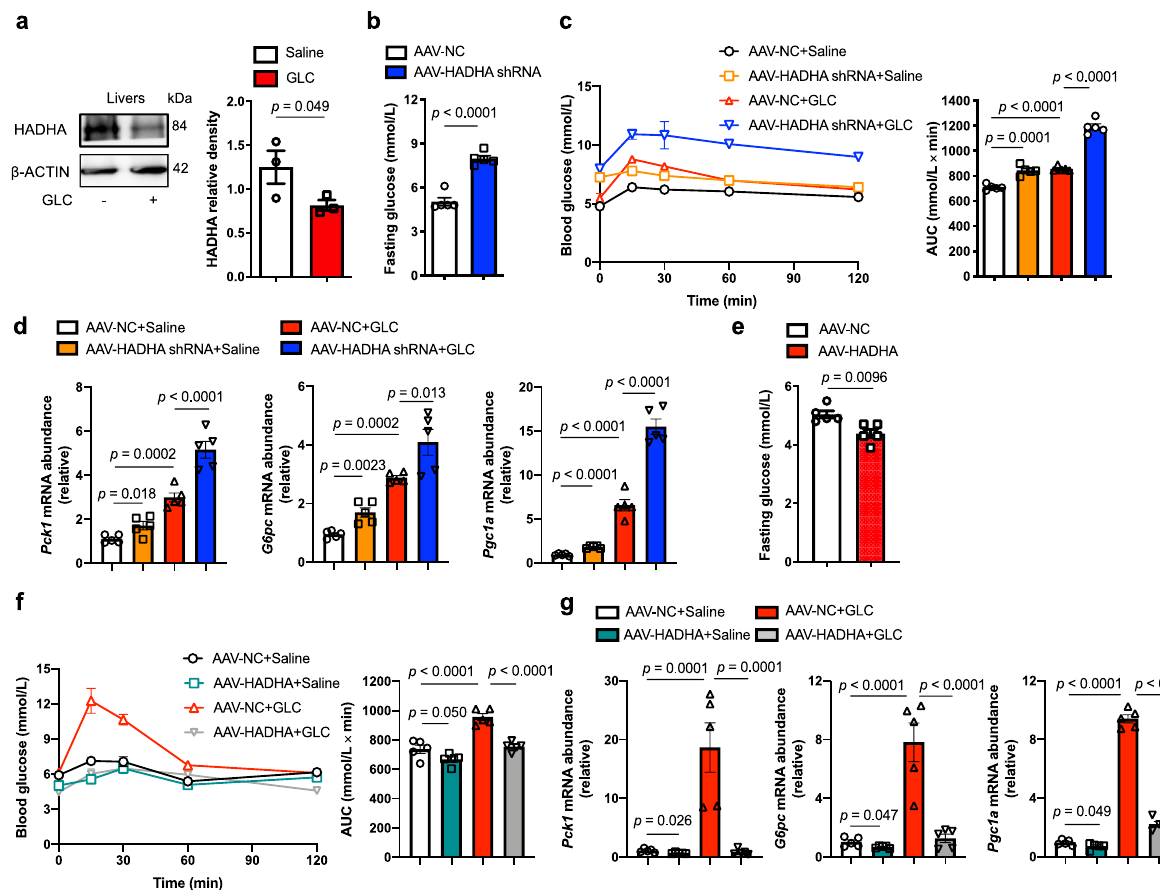
Fig. 1 HADHA inhibited glucagon-stimulated hepatic gluconeogenesis. a Hepatic HADHA protein level in glucagon-challenged mice (2 mg/kg, n = 3). b Fasting blood glucose of liver-speci fi c HADHA knockdown mice ( n = 5). c Blood glucose levels in normal mice subjected to glucagon challenge (2 mg/ kg) and treated with AAV8-HADHA shRNA or AAV8-NC. AUC is indicated on the right ( n = 5). d mRNA levels of Pck1 , G6pc and Pgc1a in the livers of